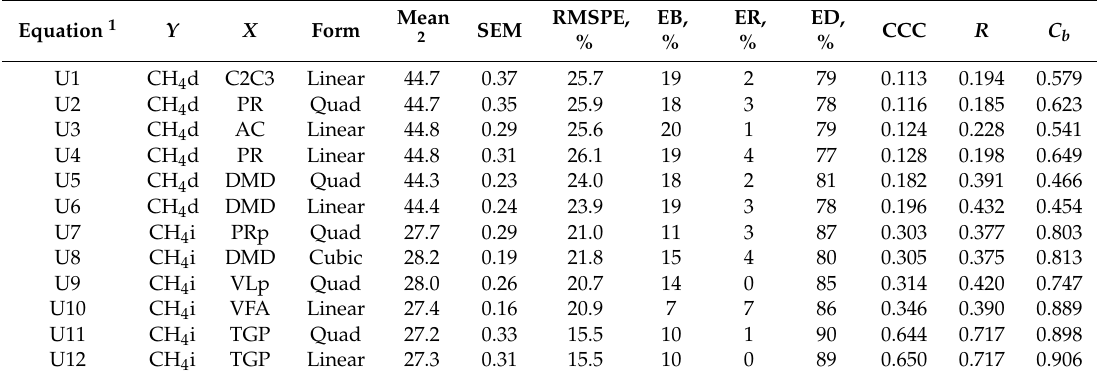
Table 3. Univariate equations—meta-analysis model evaluation via root mean square prediction error (RMSPE) and concordance correlation coe ffi cient (CCC) analysis on the internal evaluation ( n = 107)